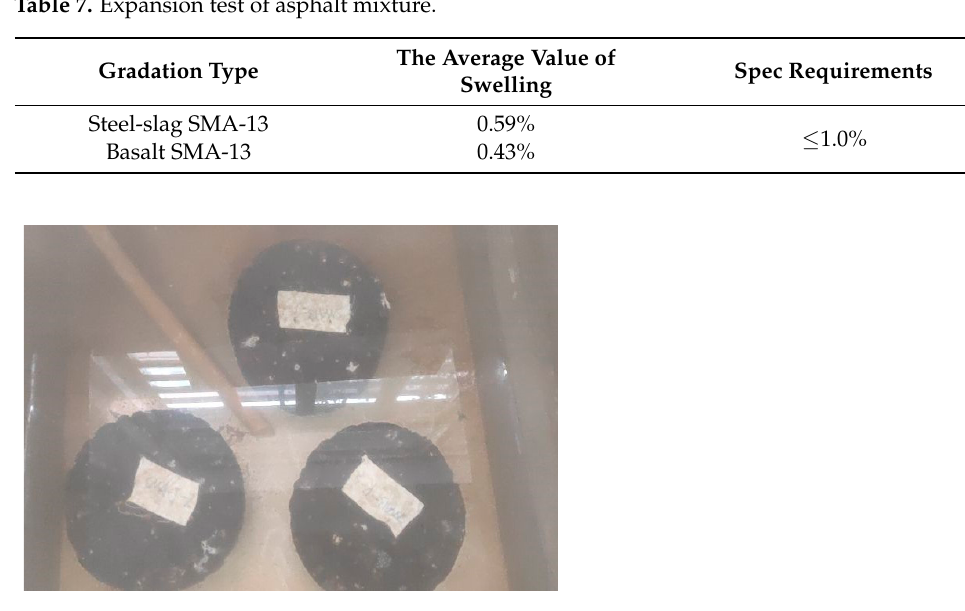
Figure 13. Freeze–thaw splitting test of mixture.